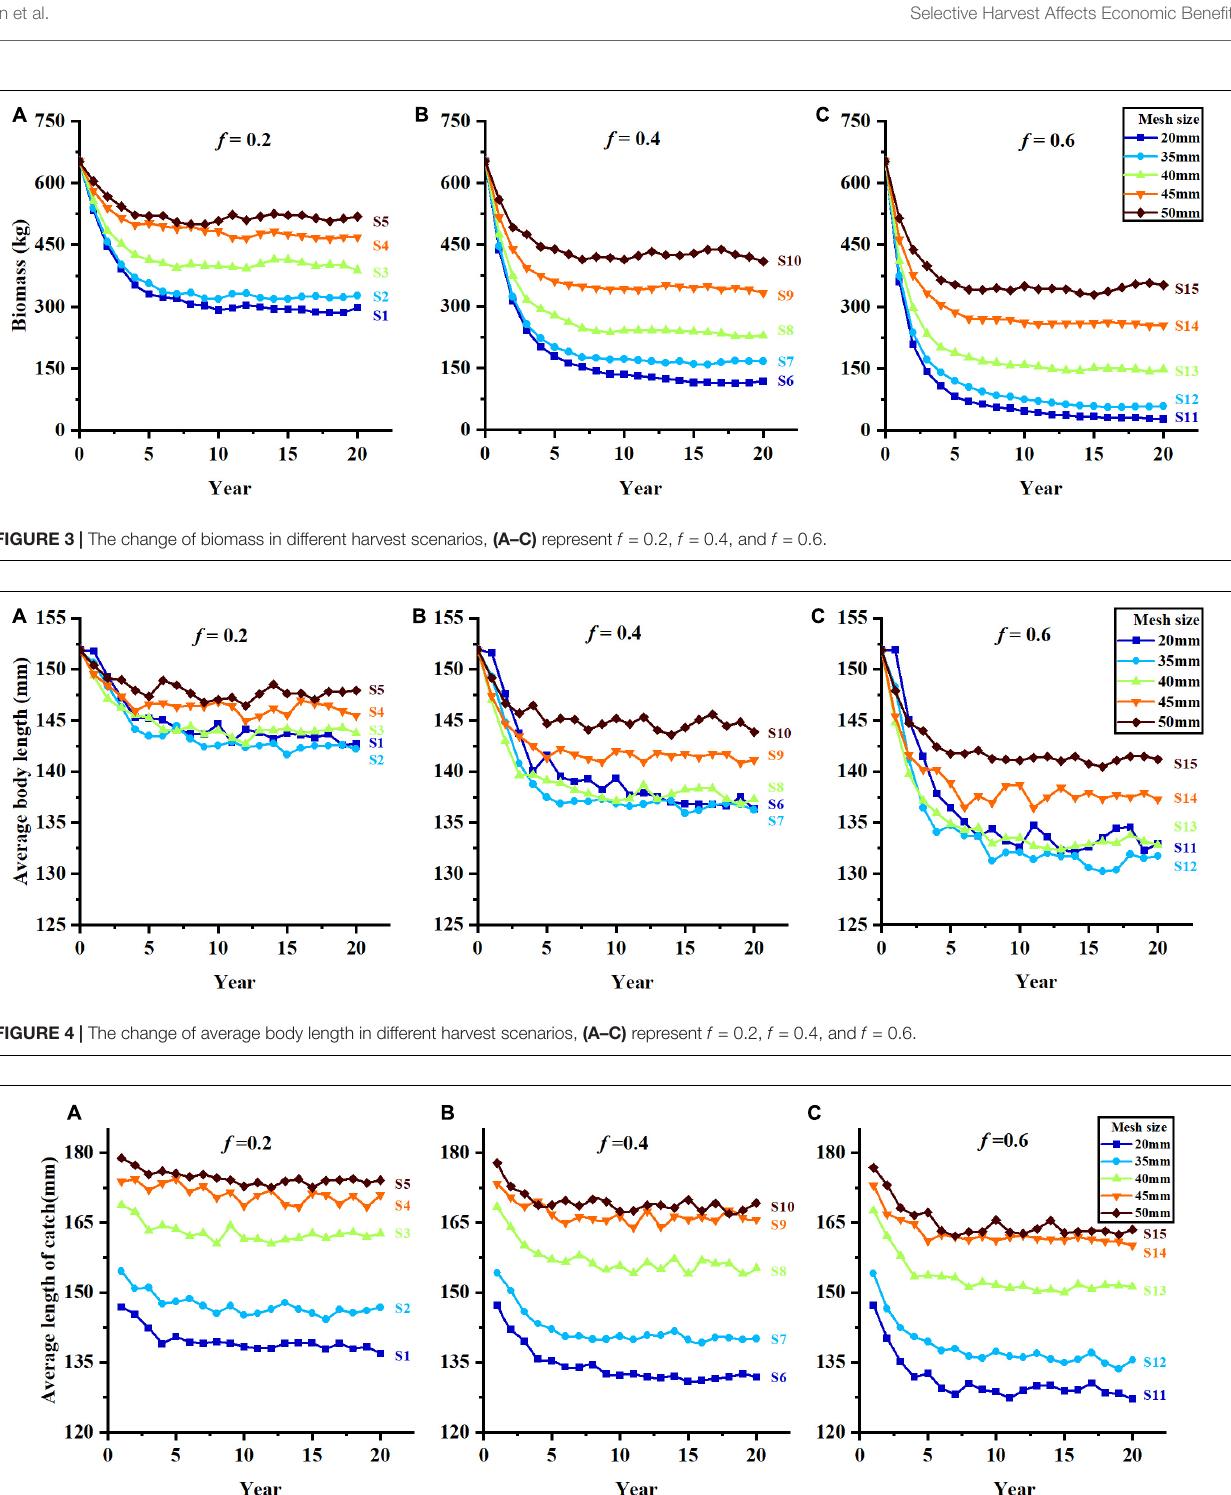
FIGURE 5 | Average length of catch in different harvest scenarios, (A–C) represent f = 0.2, f = 0.4, and f = 0.6.